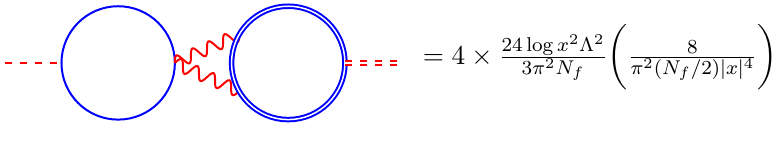
Figure 3 . Diagram responsible for mixing h (cid:27) ( x )~ (cid:27) (0) i .